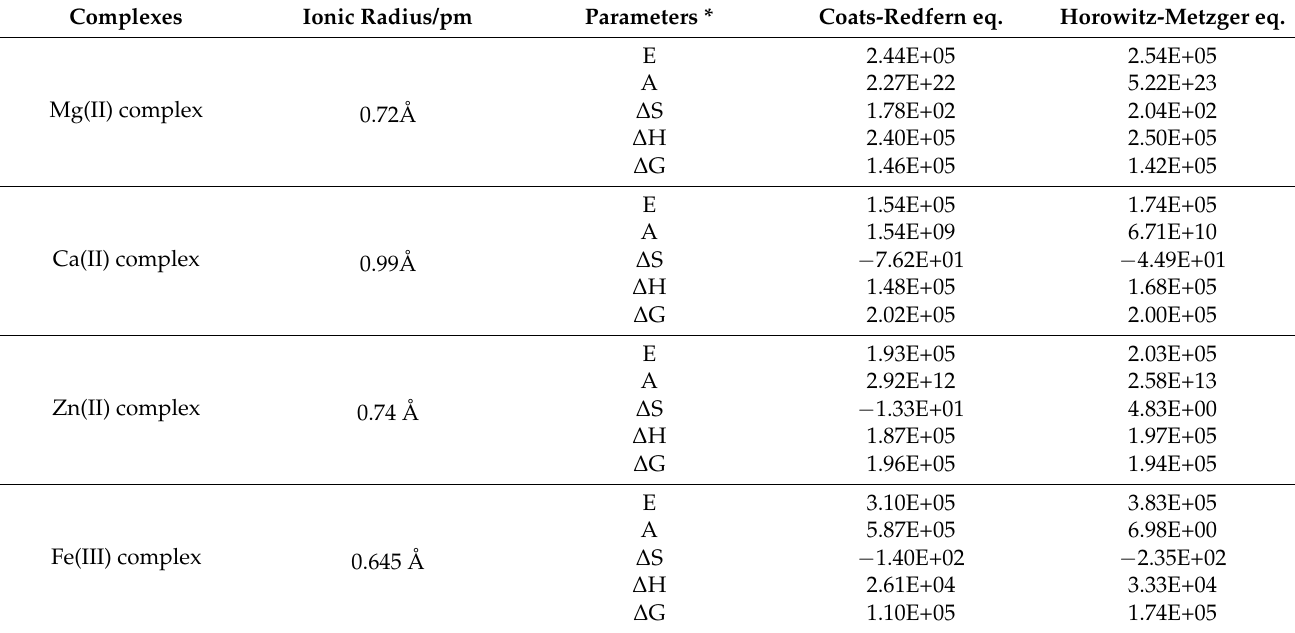
Table 5. Kinetic thermodynamic parameters data of the pip